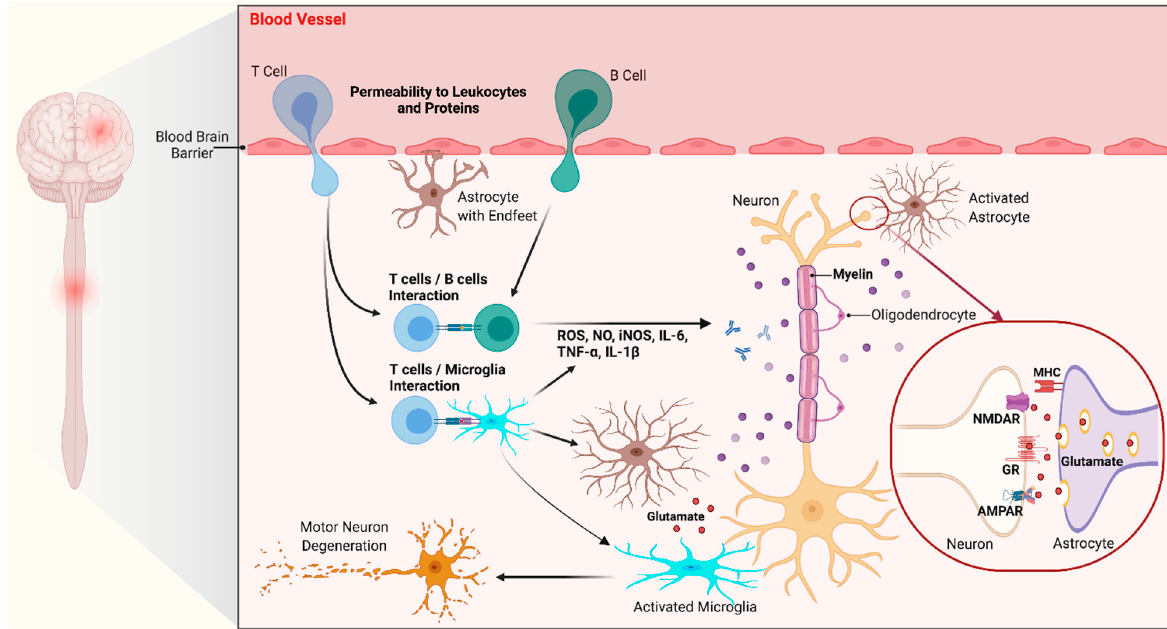
Figure 4. Pathogenic mechanisms underlying glial cell toxicity in neurodegeneration. Microglia and astrocytes become overactivated and lead to neurotoxicity through several mechanisms. Activated microglia and astrocytes produce excess noxious pro-inflammatory factors, such as nitric oxide (NO), reactive oxygen species (ROS, e.g., H 2 O 2 and ONOO − ), several cytokines (e.g., interleukin [IL]-1 β , IL-6, and tumor necrosis factor [TNF]- α ), and glutamate. AMPAR, α -amino-3-hydroxy- 5-methyl-4-isoxazolepropionic acid (AMPA) receptor; GR, glutamate receptor; MHC, major histocompatibility complex; and NMDAR, N -methyl-D-aspartate (NMDA)